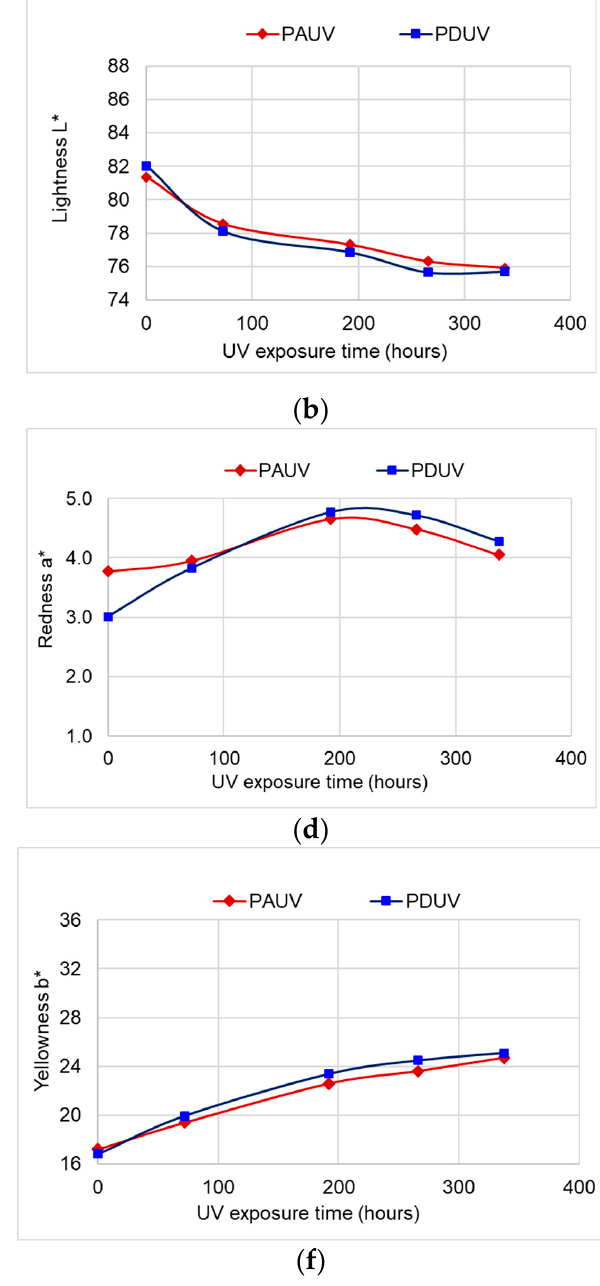
Figure 5. The variation of color parameters with an increase in UV exposure time: ( a ) lightness of spruce samples; ( b ) lightness of sycamore maple samples; ( c ) redness of spruce samples; ( d ) redness of sycamore maple samples; ( e ) yellowness of spruce samples; ( f ) yellowness of sycamore maple samples.